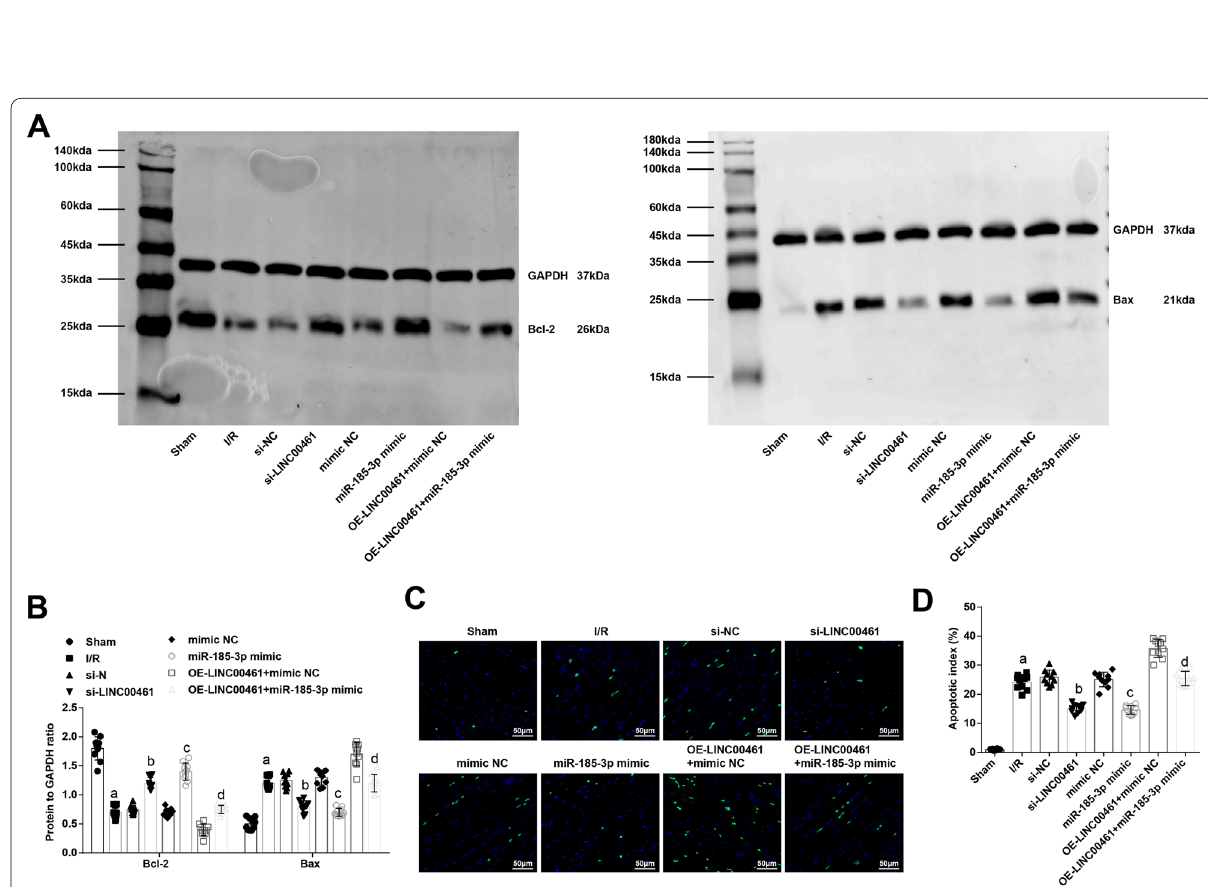
Fig. 5 Restored miR-185-3p or depleted LINC00461 suppresses apoptosis of cardiomyocytes in I/R mice. A , B Comparison of Bcl-2 and Bax protein expression in the myocardial tissue of mice. C , D Comparison of cardiomyocyte apoptosis in the myocardial tissue of mice. a P < 0.05 vs. the sham group. b P < 0.05 vs. the si-NC group. c P < 0.05 vs. the mimic-NC group. d P < 0.05 vs. the OE-LINC00461